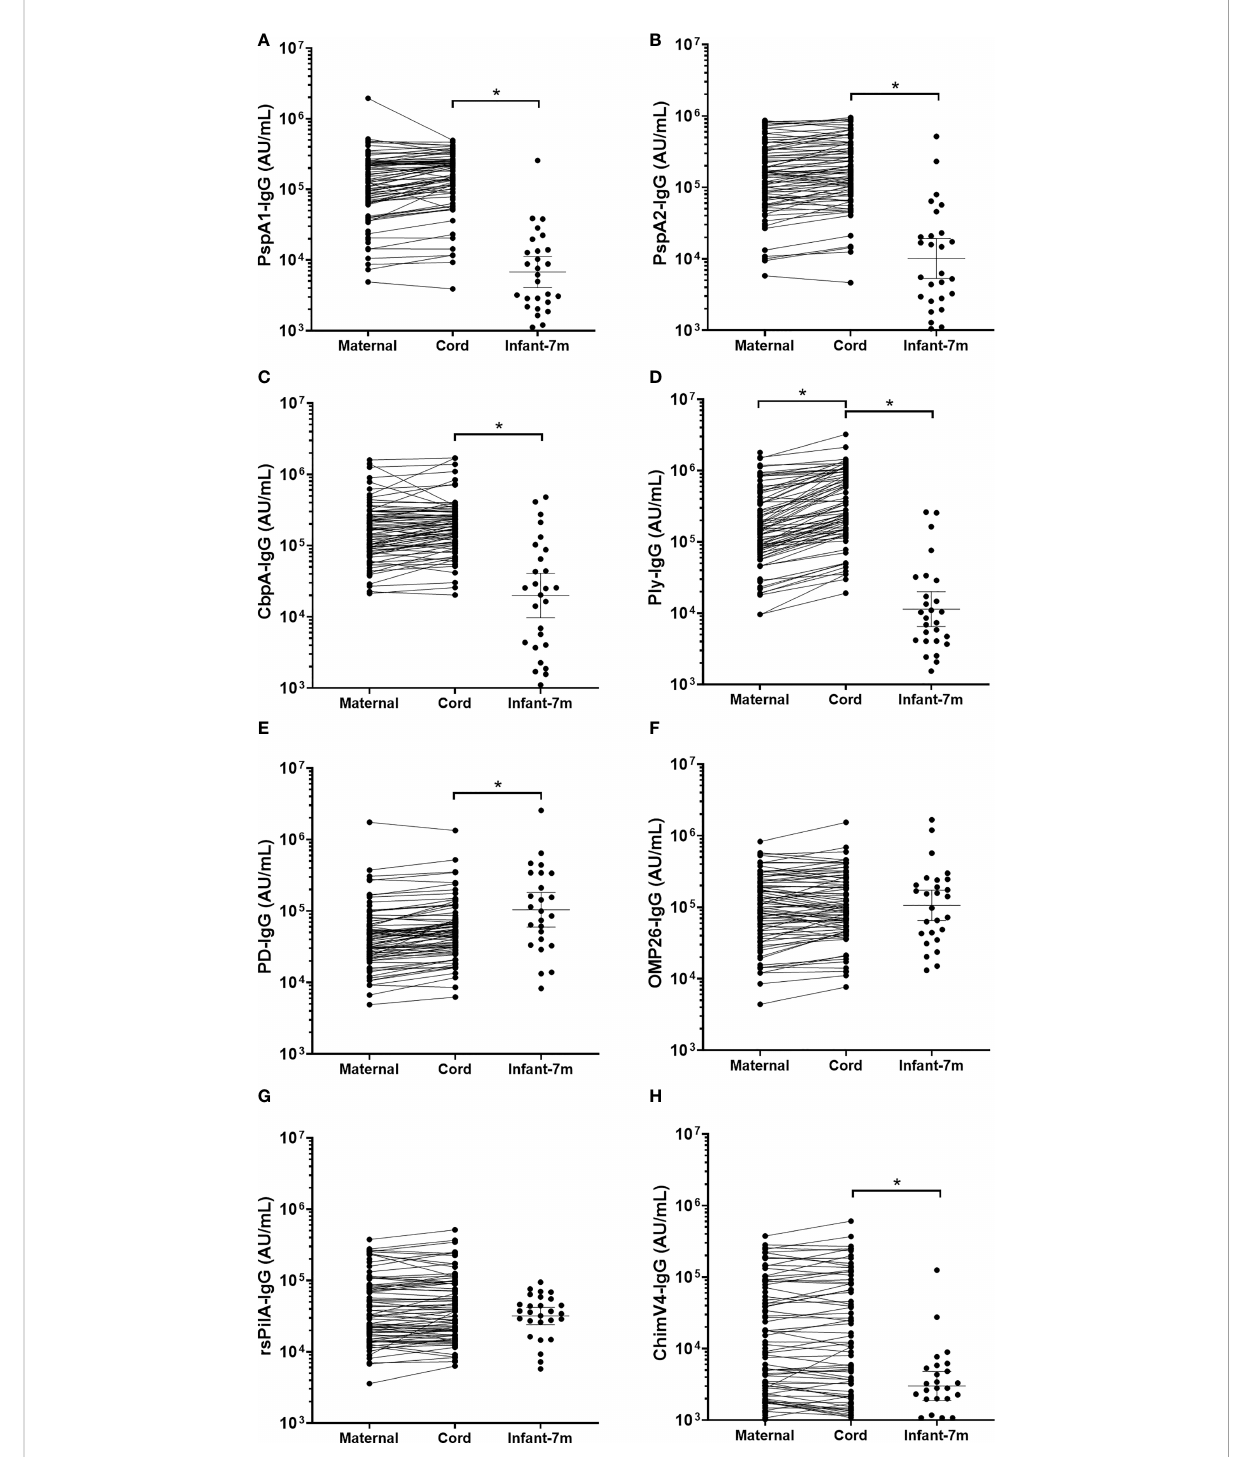
FIGURE 2 IgG titres against Streptococcus pneumoniae and Haemophilus in fl uenzae antigens in maternal, cord and infant sera. Each point represents sera IgG titres against S. pneumoniae antigens (A) PspA1, (B) PspA2, (C) CbpA, (D) Ply and H. in fl uenzae antigens (E) PD, (F) OMP26, (G) rsPilA and (H) ChimV4. PspA1, pneumococcal surface protein A family 1; PspA2, pneumococcal surface protein A family 2; CbpA, choline-binding protein A; Ply, pneumolysin. PD, Protein D; OMP26, outer membrane protein 26; rsPilA, recombinant soluble pilus A protein; ChimV4, chimeric vaccine antigen 4 (rsPilA and P5). * p-value <0.05, Paired t-tests were conducted on the logarithmically transformed data. All samples had measurable antibody